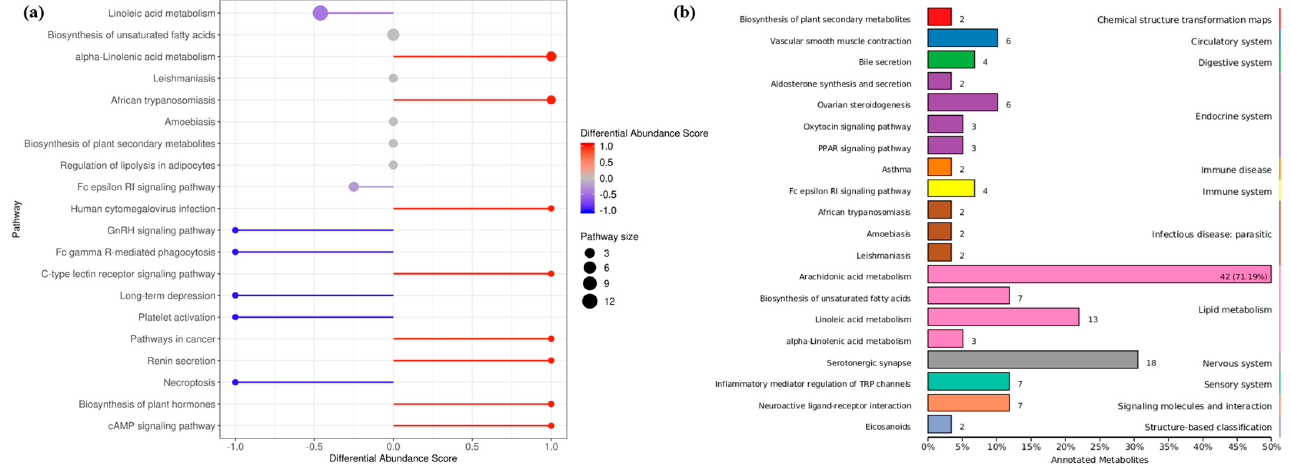
Figure 5. Annotated classification statistical map of differentially oxidized lipid metabolites. ( a ) Differential metabolite abundance score map ( b ) KEGG functional enrichment of all differential metabolites. It consists of twelve primary terms (listed on the right axis) as well as twenty secondary terms (listed on the left axis).